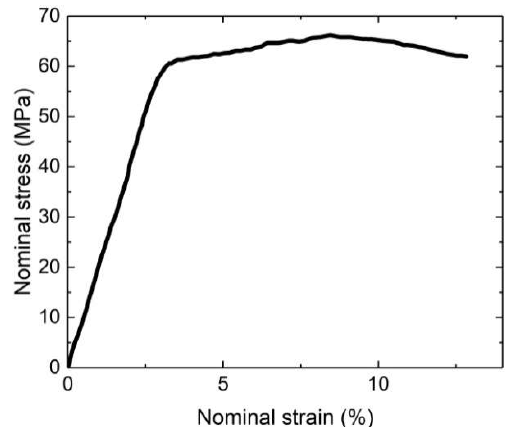
Figure 3. Stress–strain curve of the bismuth antimony (Bi 1− x Sb x ) sample deformed at room temperature under a constant strain rate of 1 × 10 −5 s −1 . The Sb concentration of the deformed sample was in the range of 8.6–9.8 at%.